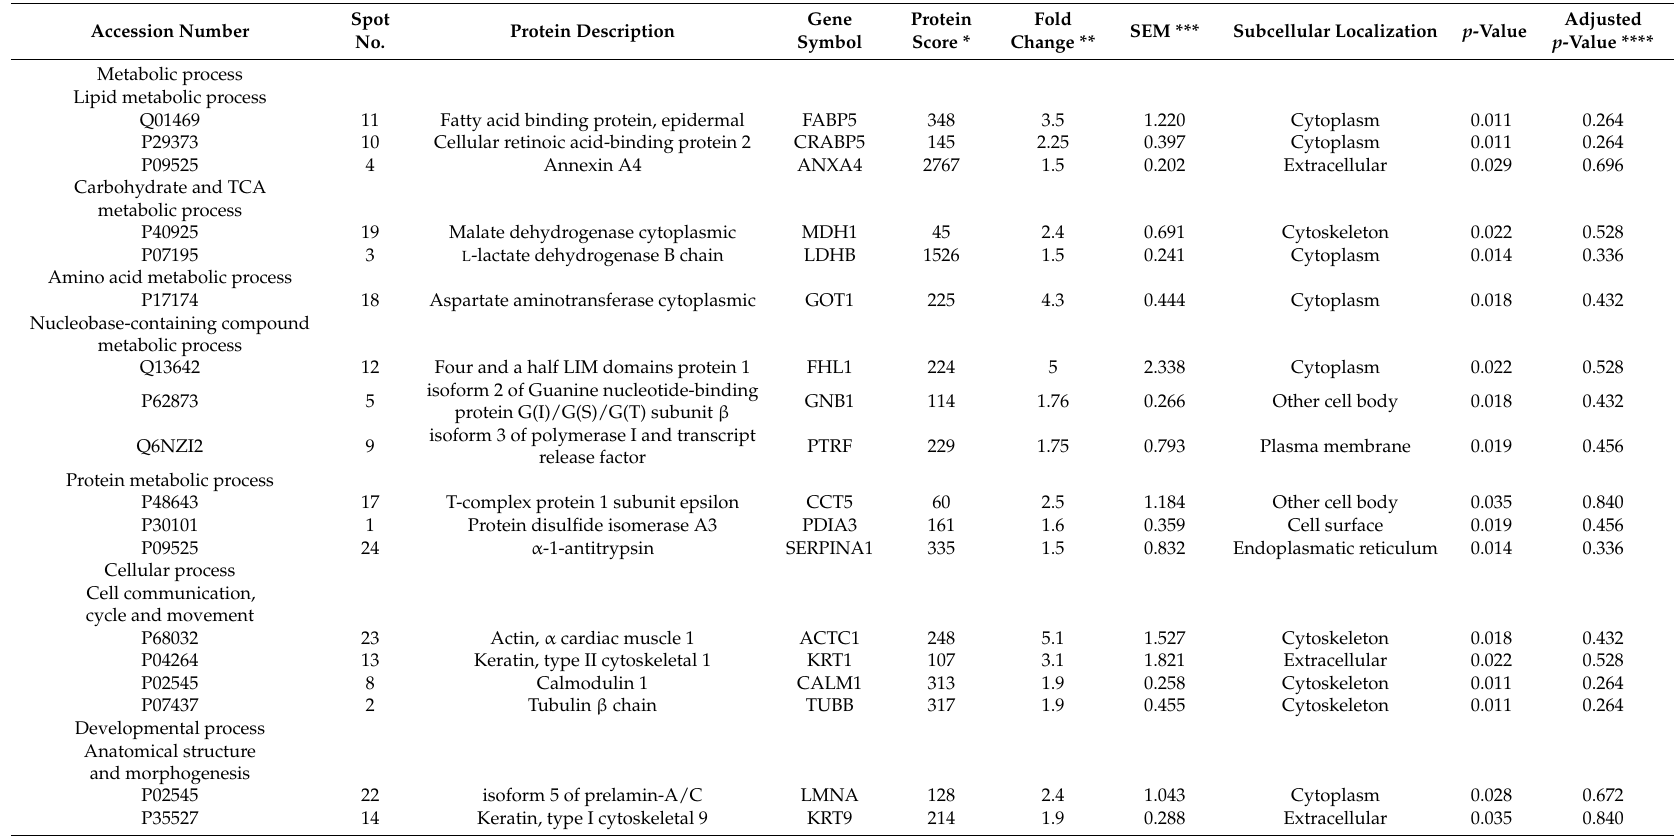
Table 1. Protein expression levels measured in the leiomyoma and in the myometrium proteome as identified by MALDI-TOF/TOF or LTQ-Orbitrap XL mass spectrometer and classified by their corresponding biological process and subcellular localization. Only the most relevant biological processes are reported.